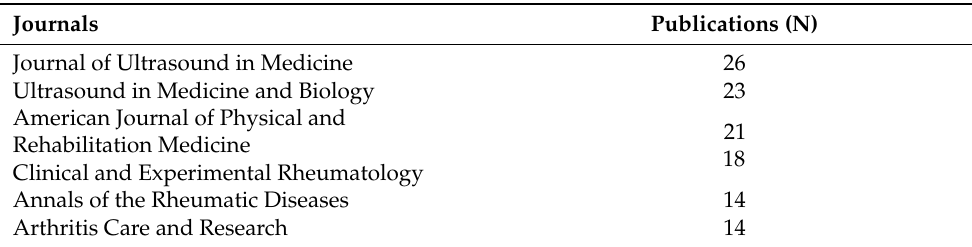
Table 1. Top six journals that published on ‘ultrasound examination’ of the musculoskeletal system. Total number of journals that published on ‘ultrasound examination’ of the musculoskeletal system = 160 journals.